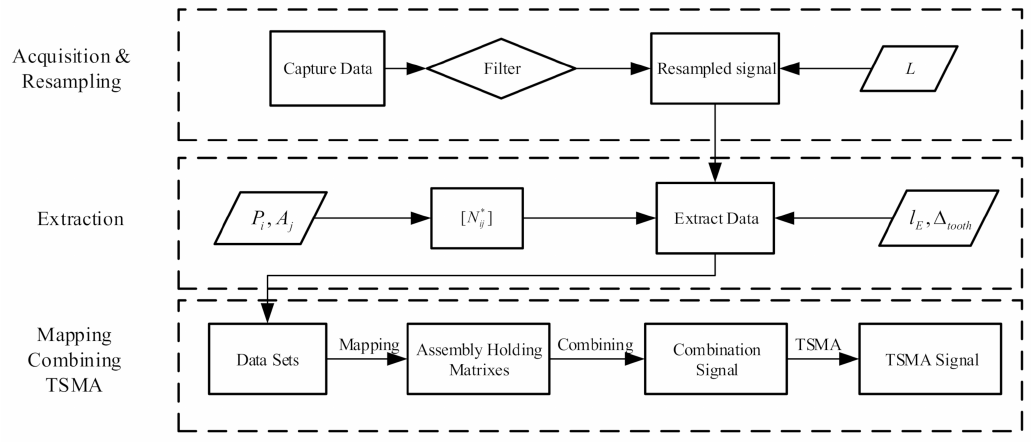
Figure 7. Procedure of continuous vibration separation